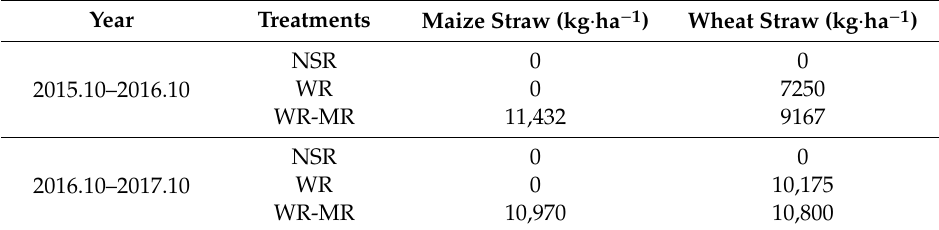
Table 1. The rate of straw returned to the